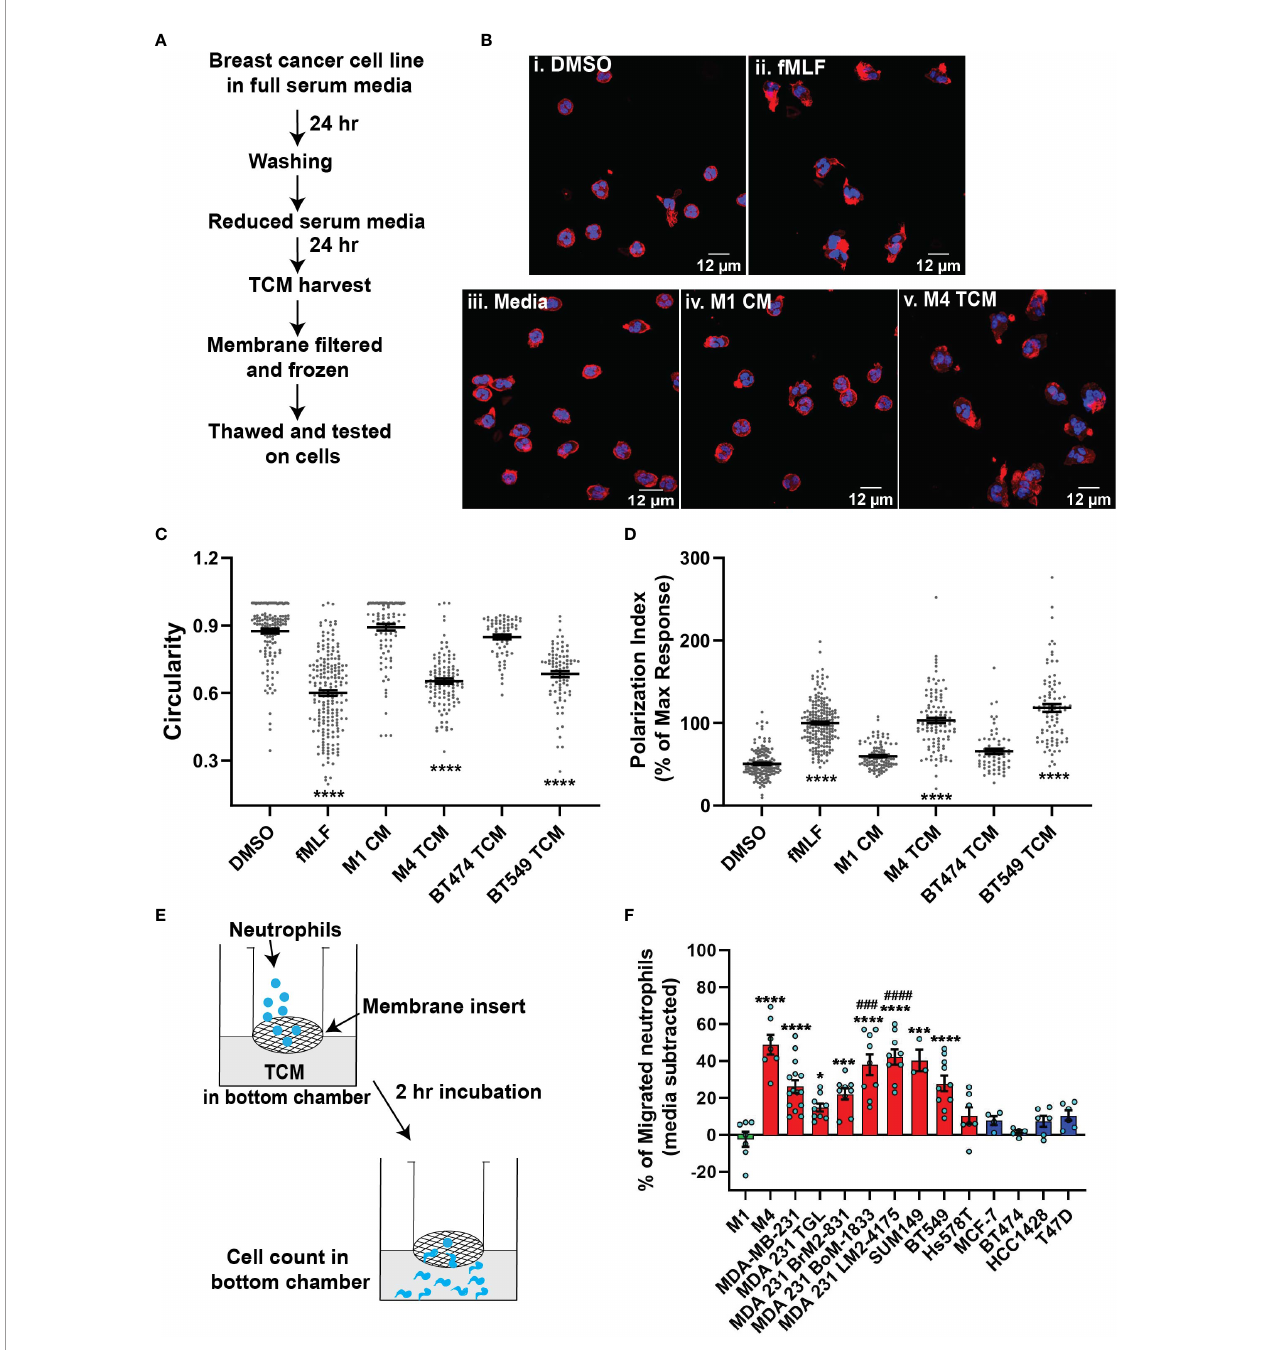
FIGURE 1 | TCM derived from TNBC cell lines induce neutrophil migration. (A) Flowchart describing how TCM was generated and harvested from cell lines grown under serum reduced conditions. (B) Representative maximum intensity projection confocal images showing fi xed neutrophils stimulated with (i), DMSO, (ii) 100 nM fMLF, equal volume of (iii) media, (iv) M1 CM or (v) M4 TCM, and stained for F-actin with phalloidin-TRITC (red) and nuclei with DAPI (blue). Scale bars are 12 µm. (C, D) Graphs depicting the circularity (C) and polarization (D) index of neutrophils stimulated with controls or equal volume of TCM derived from different breast cancer cell lines. Each dot represents corresponding value of a single neutrophil for each condition. (E) Cartoon depicting the neutrophil transwell migration assay. (F) Graph depicting the percentage of neutrophils that migrated into the bottom chamber of the transwells containing equal volume of CM from M1 cells or TCM from different breast cancer cell lines. Red and blue bars represent values of neutrophil migration obtained with TCM harvested from TNBC and ER+ cancer cell lines, respectively. Data shown are mean ± SEM from N=4 (C, D) or 3-15 (F) independent donors represented by individual dots. Each donor (N) represents an independent experiment. ****P ≤ 0.0001, ***P ≤ 0.001, *P ≤ 0.05 when compared with M1 CM (C, D, F) or #### P ≤ 0.0001 and ### P ≤ 0.001 when compared with MDA 231 TGL (one-way ANOVA with Dunnett ’ s multiple comparisons